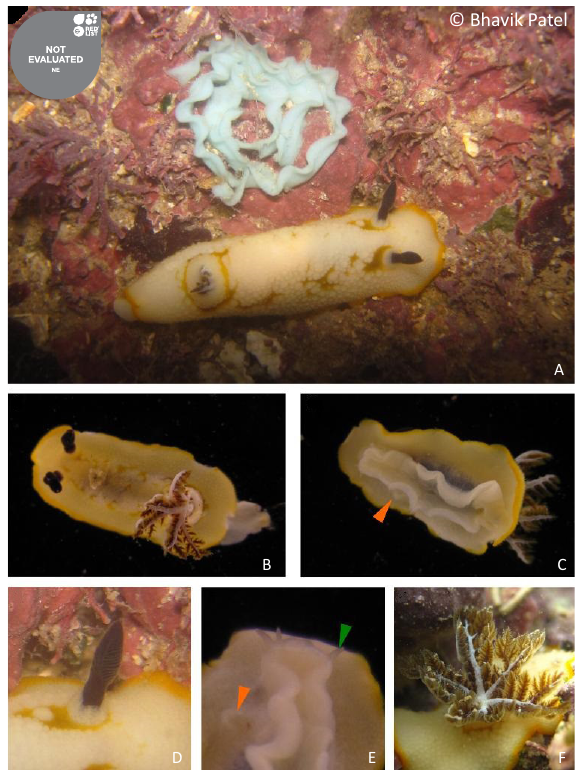
Image 1. Map showing location of recorded species from Dwarka, Gujarat, India.